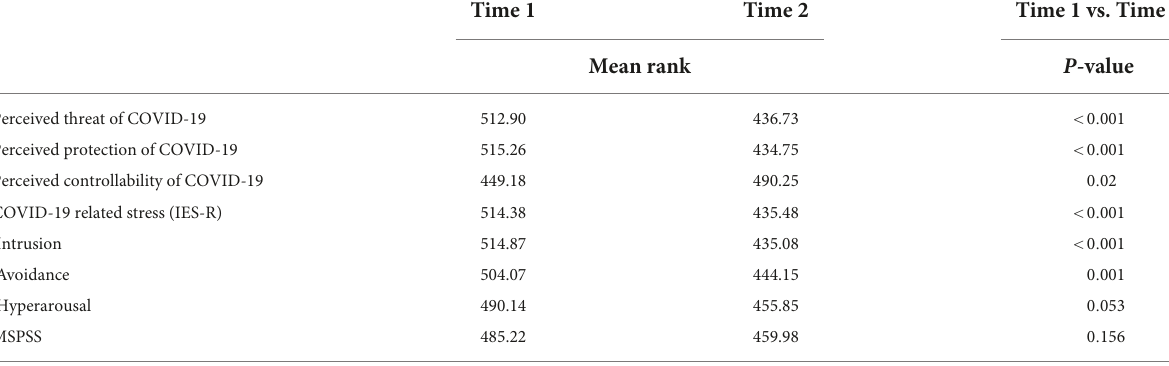
TABLE 2 Self-reported scores during the first wave of COVID-19 and 1 year later.